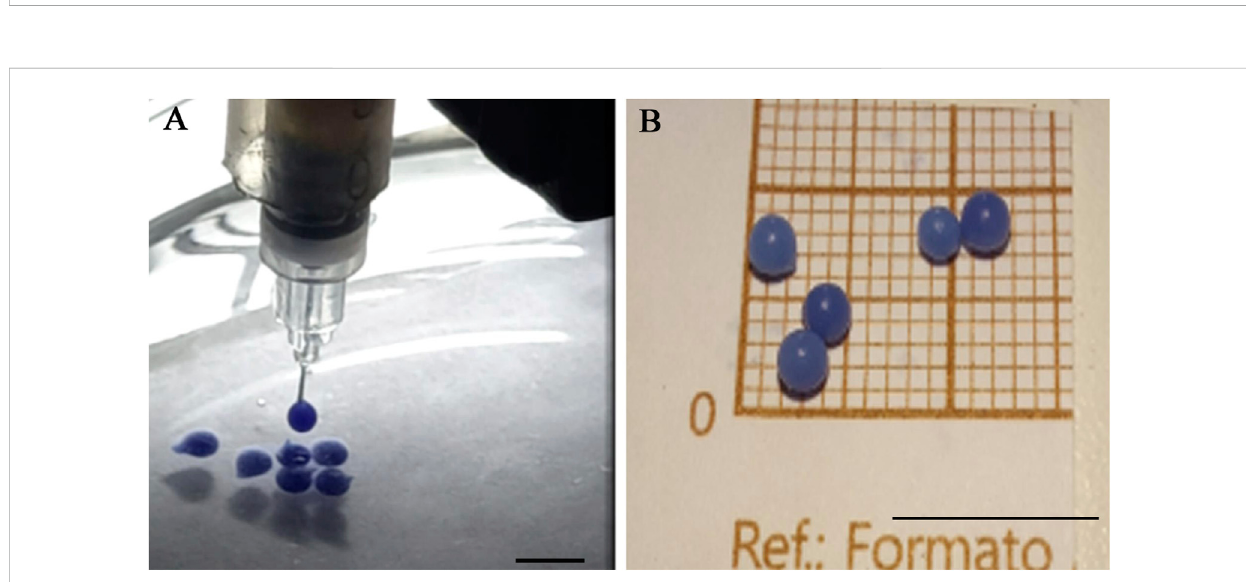
FIGURE 8 Alginate geli fi cation in calcium chloride: (A) dripping and (B) appearance of the gelled capsules. Scale bar 1 cm.